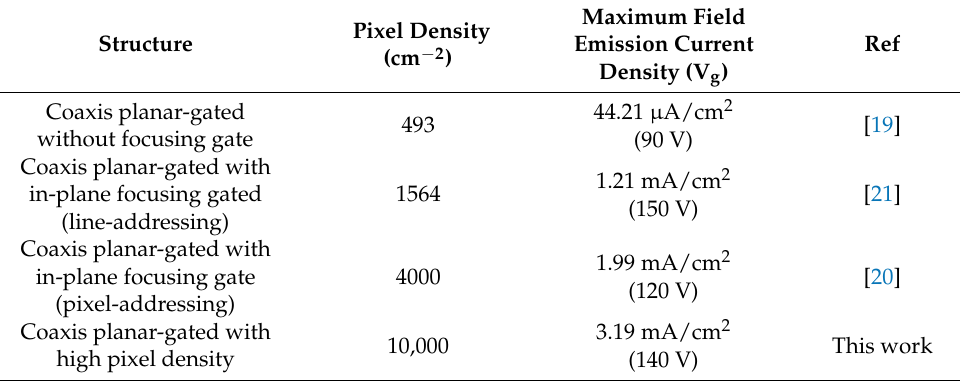
Table 2. Comparison of the structure, pixel density and emission properties of gated ZnO nanowire FEAs reported in the previous